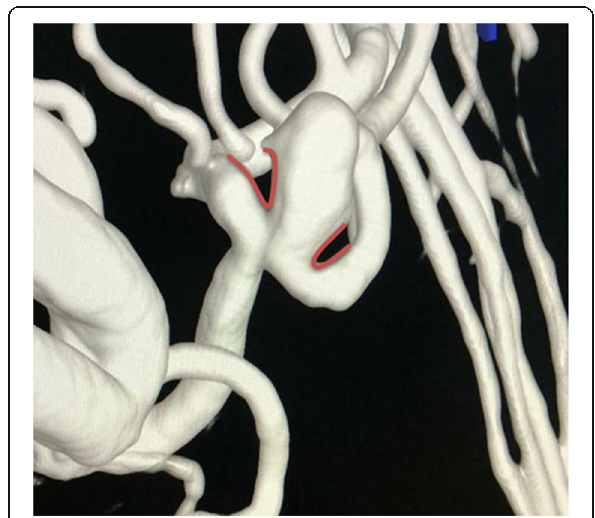
Fig. 1 3D CTA showing Acom aneurysm; the angles drawn in red showing the open aneurysm A2 angle; here, easy aneurysm dissection and clip placement is expected